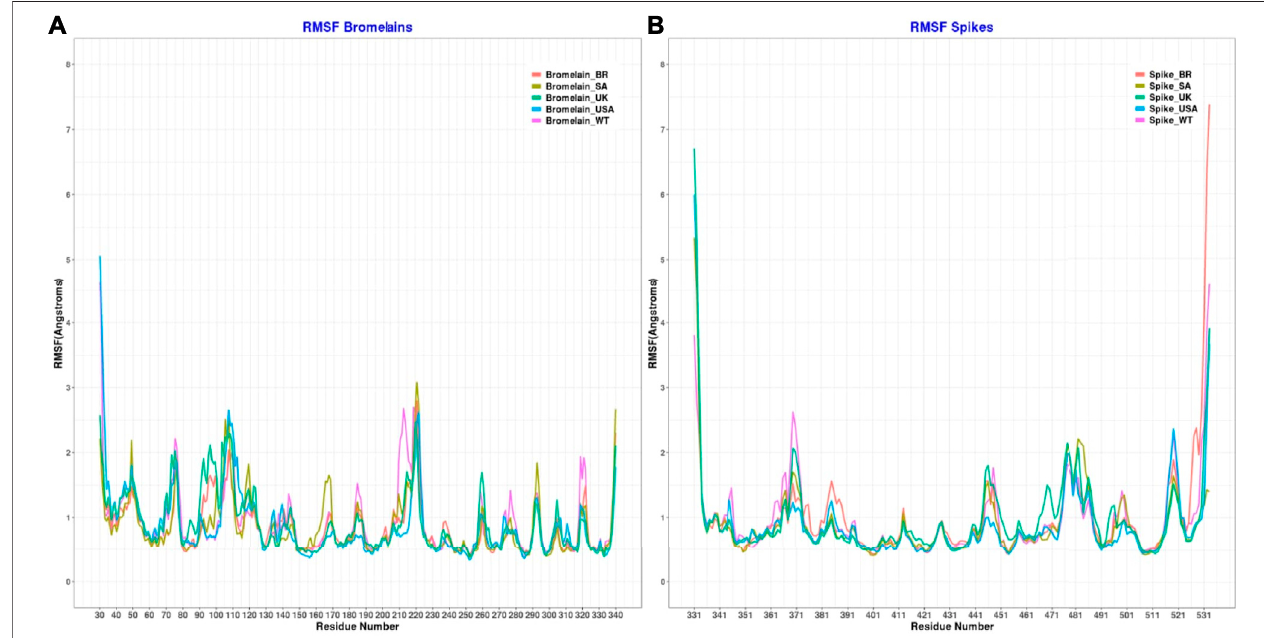
FIGURE 11 | Root mean square fl uctuation of (A) the complex of bromelain and RBDs, and (B) the RBDs.